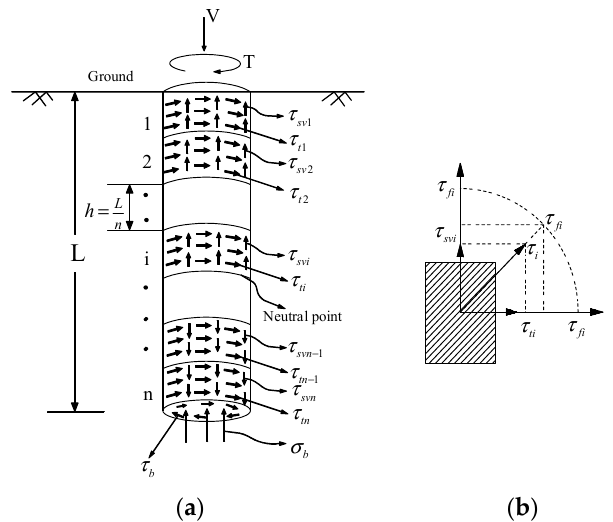
Figure 5. ( a ) Discrete model of pile surface ( b ) Shear element